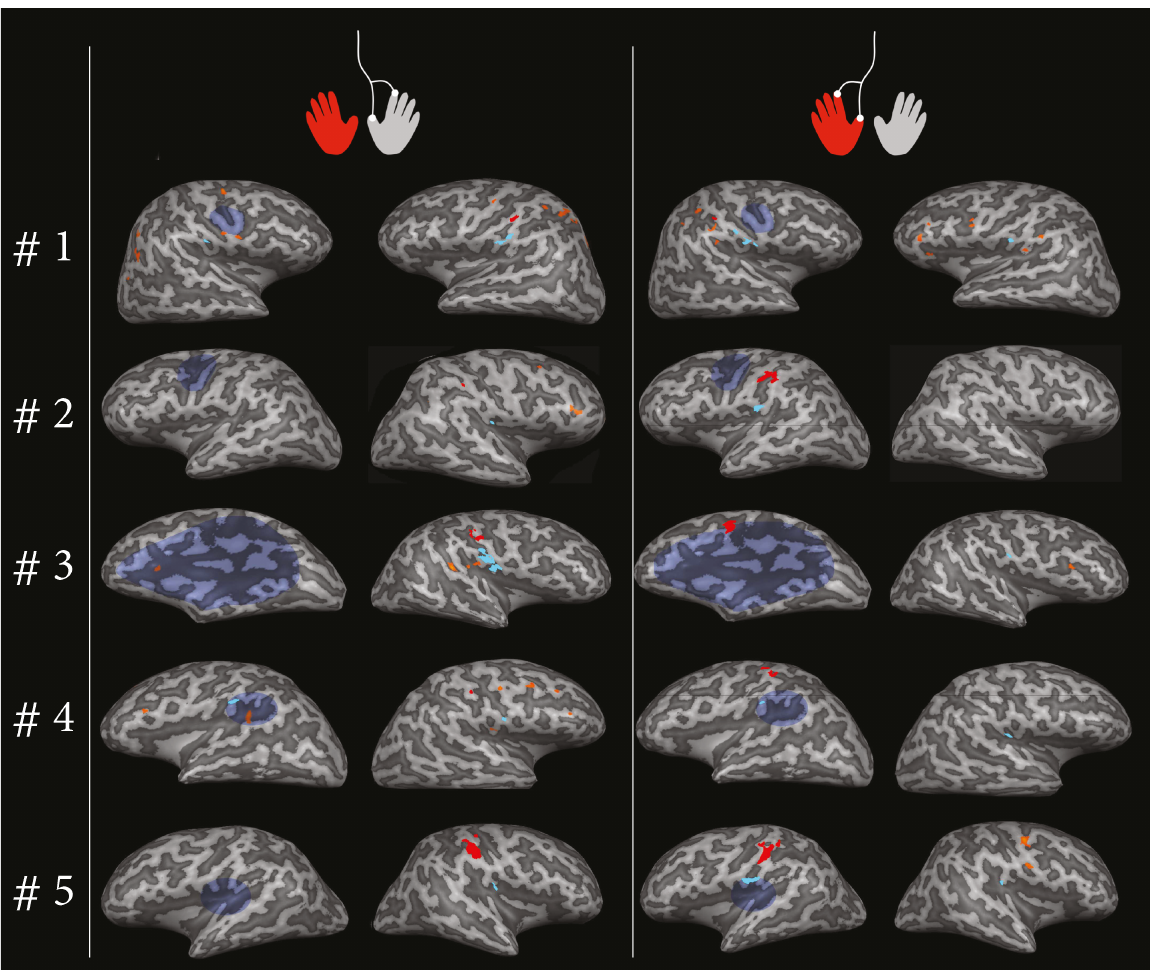
Figure 2: Activation foci for tactile stimulation of both hands, represented on in fl ated cortices in the native space of each single subject. Subjects ’ identi fi ers are shown in the left column, accordingly to Tables 1 and 2. For subject #6, segmentation failed due to the presence of extensive polymicrogyria in lesioned hemisphere, so the representation is missing in this fi gure. For each subject, the lesion is represented in colored blue transparency on the in fl ated cortex, approximately corresponding to its anatomical projection on brain surface. S1 responses to tactile stimulation are represented in red, while S2 responses are represented in cyan. Further activation in addition to S1 and S2 for the stimulation of the dominant hand was the following (middle column): #1 HH: PrCG BA 4, IPL BA 40, SPL BA 7, SOG BA